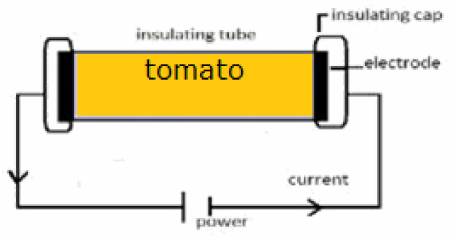
Figure 1. Schematic representation of